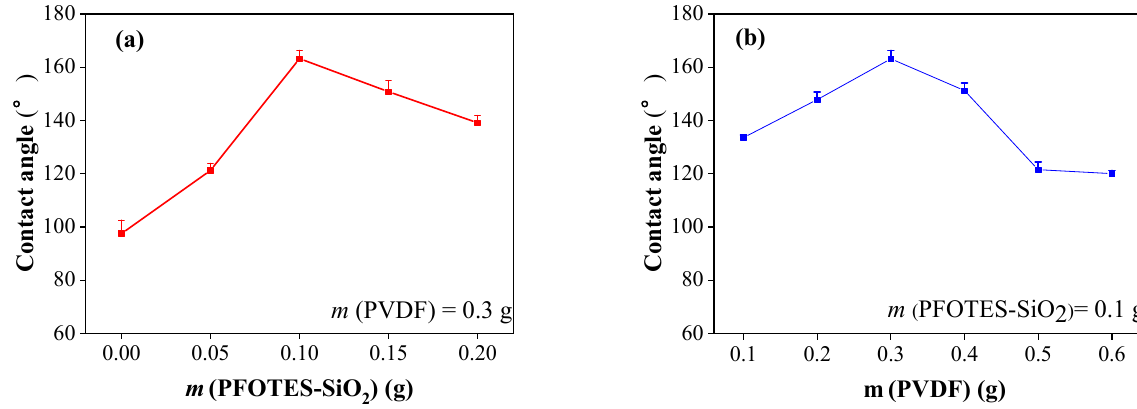
Figure 2. Influence of each variable on wettability of the surface: ( a ) PFOTES-SiO 2 , ( b ) PVDF.